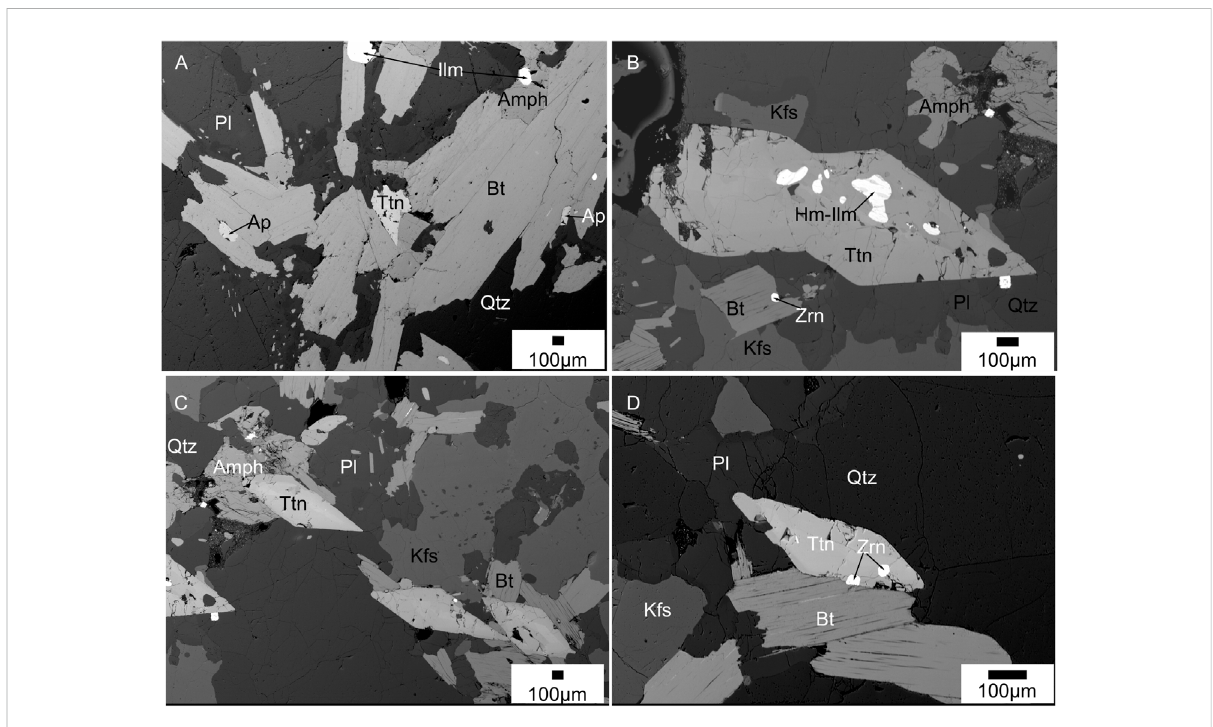
FIGURE 7 Back scattered electron images of titanite (sphene) formation in Hb-Bt gneiss samples. (A) Titanite and apatite associated to biotite laths; (B) Hemo-ilmenite inclusions in titanite associated to plagioclase-K-feldspar-quartz-biotite-amphibole matrix; (C) titanite grains associated